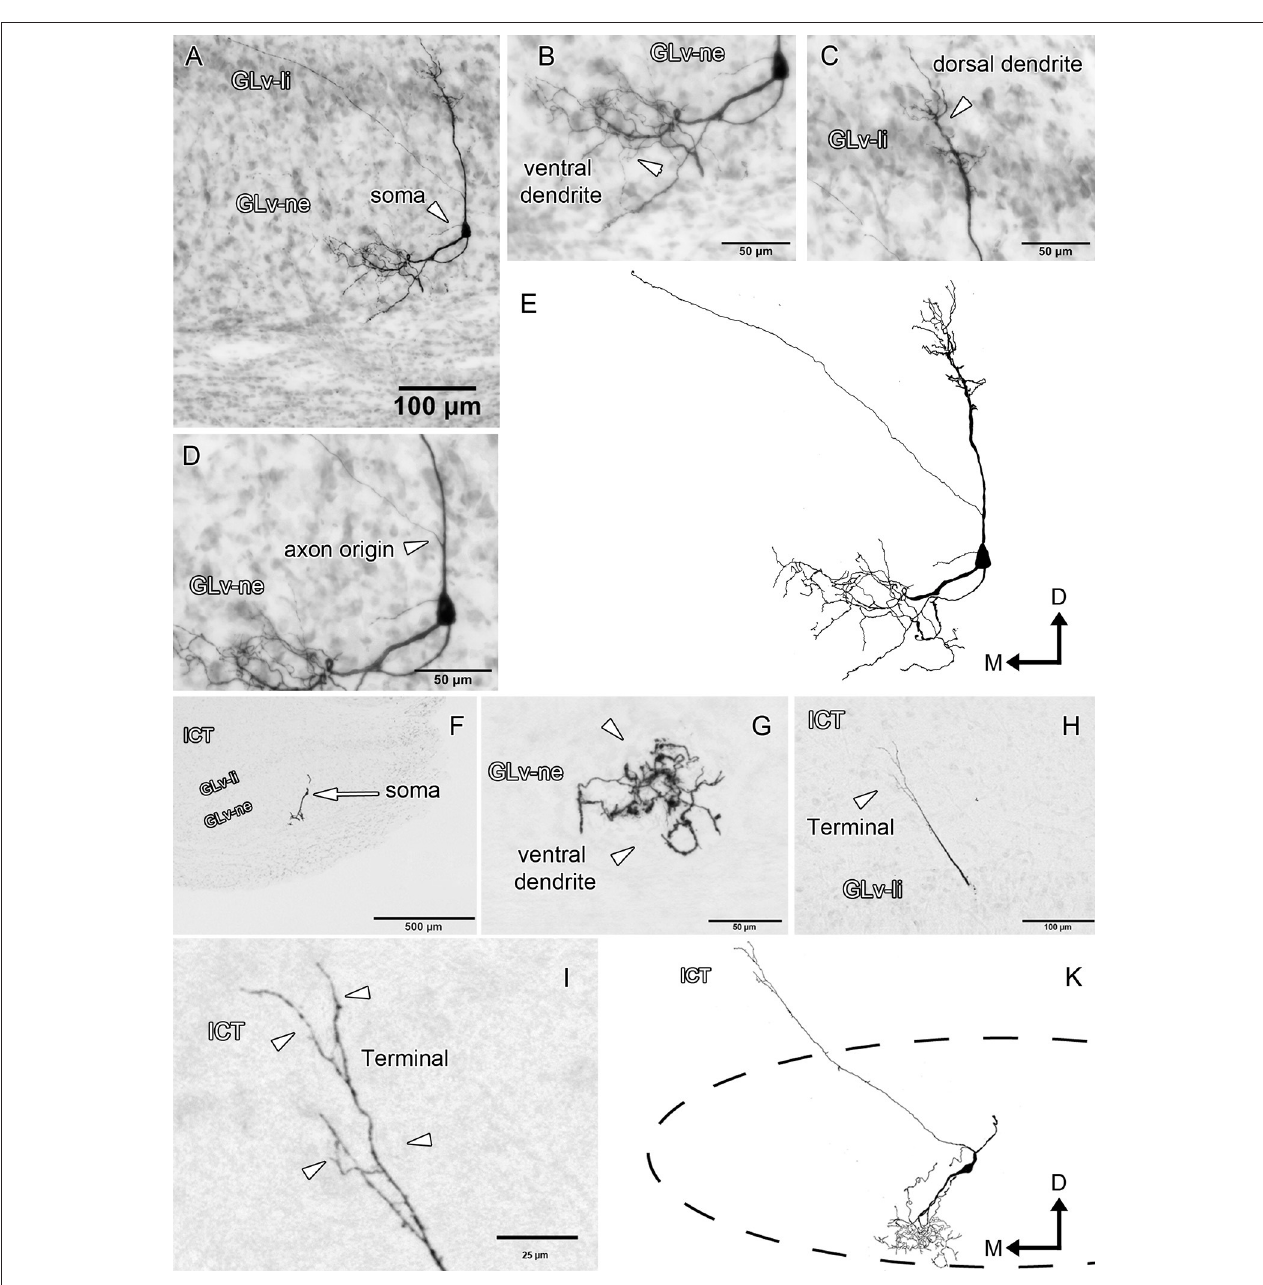
FIGURE 3 | Intracellular filling of two representative GLv-ne type I cells. (A–I) Photomicrographs showing soma location, axon origin, dendritic processes and terminal ending. Arrowheads indicate the different neuronal components. (E,K) Reconstruction of the biocytin-filled neurons. D, dorsal; M, medial. Orientation in (E,K) applies to (A–I)